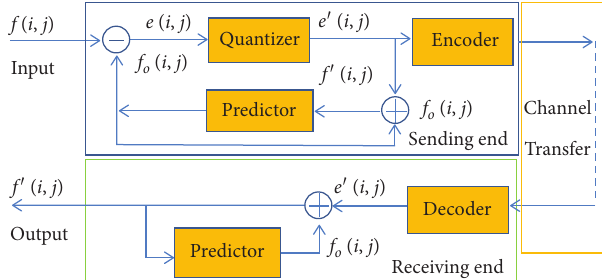
Figure 1: Flow chart of the predictive coding